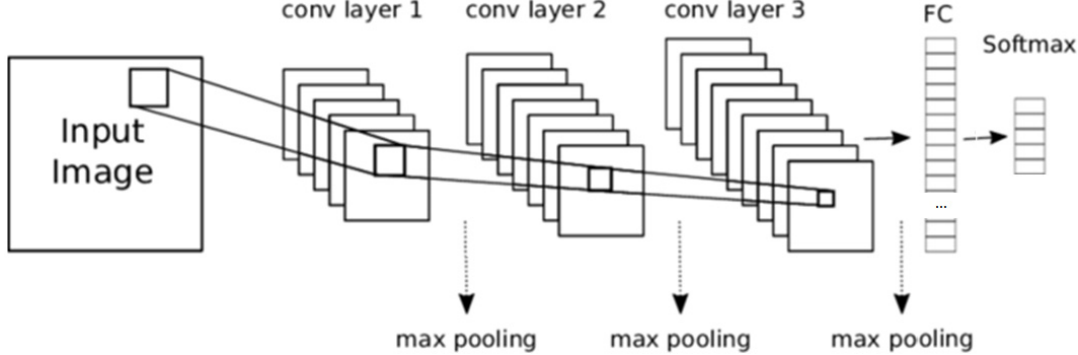
Figure 11. Structure of the designed CNN.